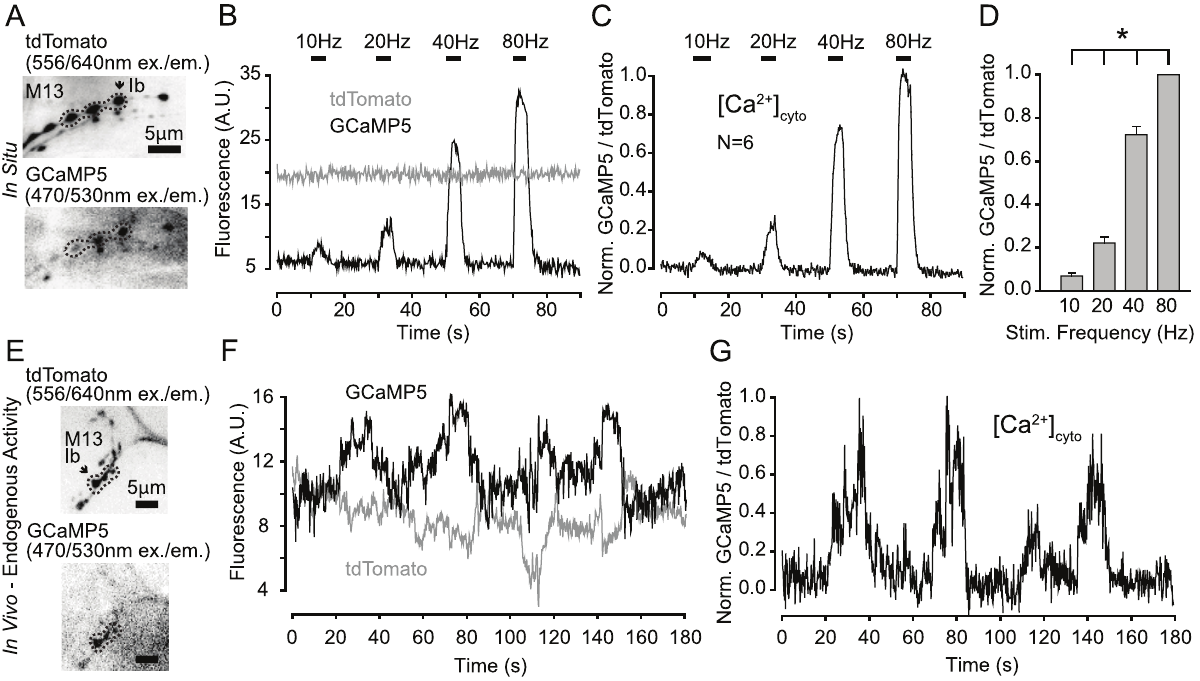
Figure 4. Application of the P2A peptide system for ratiometric calcium imaging at the larval NMJ. A. Dual-channel imaging of tdTomato (top) and GCaMP5G (bottom) at the neuromuscular junctions on muscle 13 of a dissected third instar larva expressing UAS-tdTomato-P2A– GCaMP5G driven by n-syb-Gal4 . B. Fluorescence records from MN13-Ib synaptic boutons responding to electrical stimulation of the segmental nerve at the indicated frequencies. C. GCaMP5G fluorescence data from B normalized to the simultaneously collected tdTomato signal. D. Histogram showing peak normalized GCaMP5G fluorescence intensity as a function of stimulation frequency (n=6 larvae, mean + / 2 SEM). E. Dual-channel imaging of tdTomato (top) and GCaMP5G (bottom) at the neuromuscular junctions on muscle 13 taken through the cuticle of an intact larva. F. Fluorescence records from synaptic boutons responding to endogenous bursts of action potential firing. Note the large fluctuations in tdTomato signal that are indicative of muscle contraction and associated movement artifacts. G. GCaMP5G fluorescence from panel F normalized to tdTomato signal, which reveals a more biologically-relevant signal.